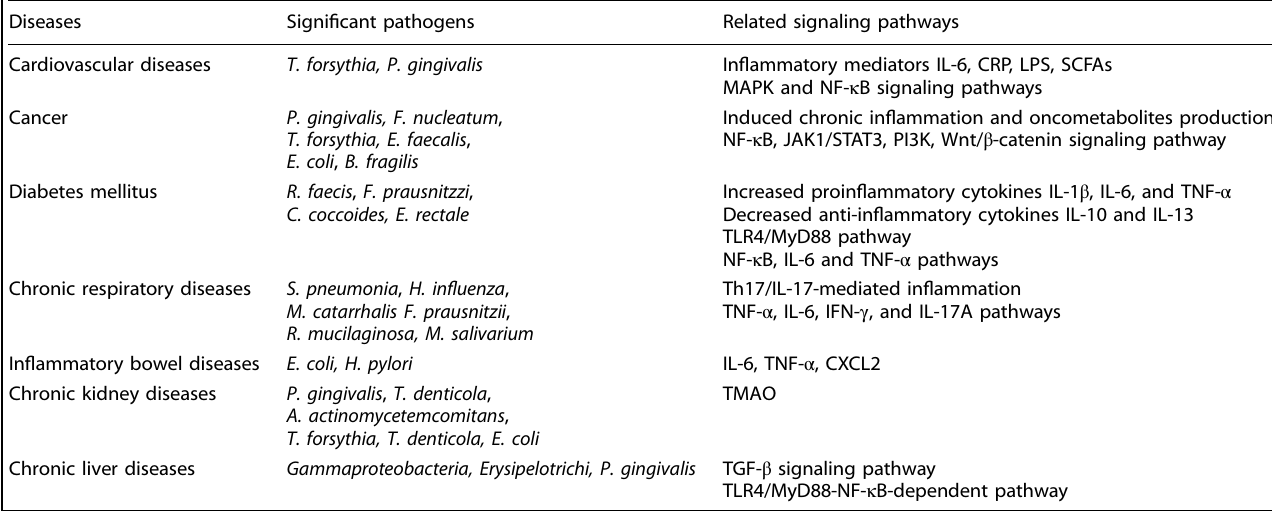
Table 2. Summary of pathogenic microbiota and the related signaling pathways